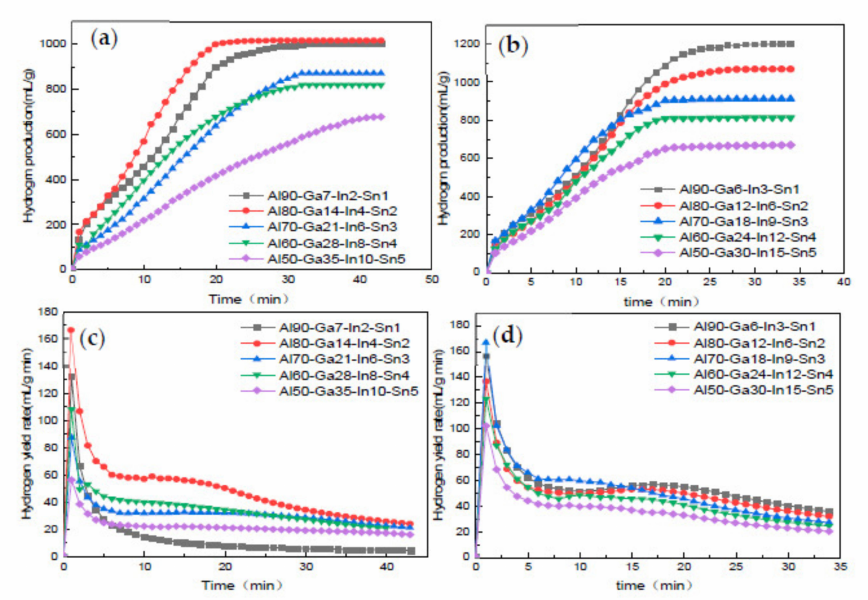
Figure 8. Comparison of the hydrogen generation performance of Al-Ga-In-Sn alloys: ( a ) hydrogen production comparison with GIS ratio 7:2:1, ( b ) hydrogen production comparison with GIS ratio 6:3:1, ( c ) hydrogen production rate comparison with GIS ratio 7:2:1, and ( d ) hydrogen production rate comparison with GIS ratio